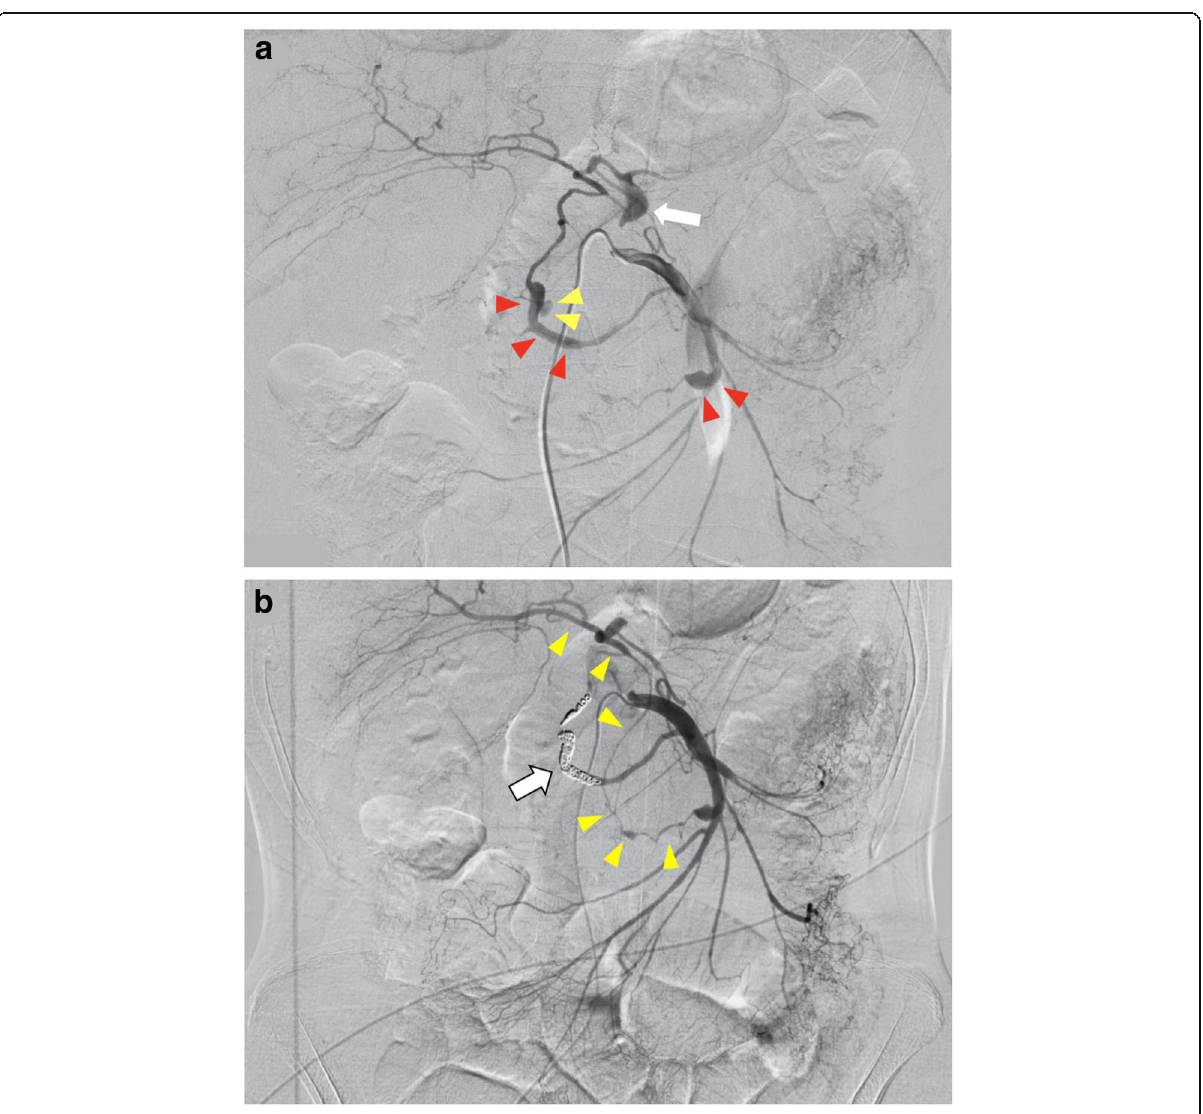
pseudoaneurysm formation were observed in posterior inferior pancreaticoduodenal artery to posterior superior pancreaticoduodenal artery and anterior inferior pancreaticoduodenal artery (shown by red arrowheads). Contrast medium extravasation from posterior inferior pancreaticoduodenal artery was observed (shown by yellow arrowheads). Irregular vasodilation and stenosis were observed in multiple arteries, which were considered to be the effect of segmental arterial mediolysis. b Embolization was performed on posterior inferior pancreaticoduodenal artery to posterior superior pancreaticoduodenal artery (shown by arrow). After coil embolization of the posterior inferior pancreaticoduodenal arterial aneurysm, the celiac arterial region was visualized from the anterior inferior pancreaticoduodenal artery via the gastroduodenal artery (shown by